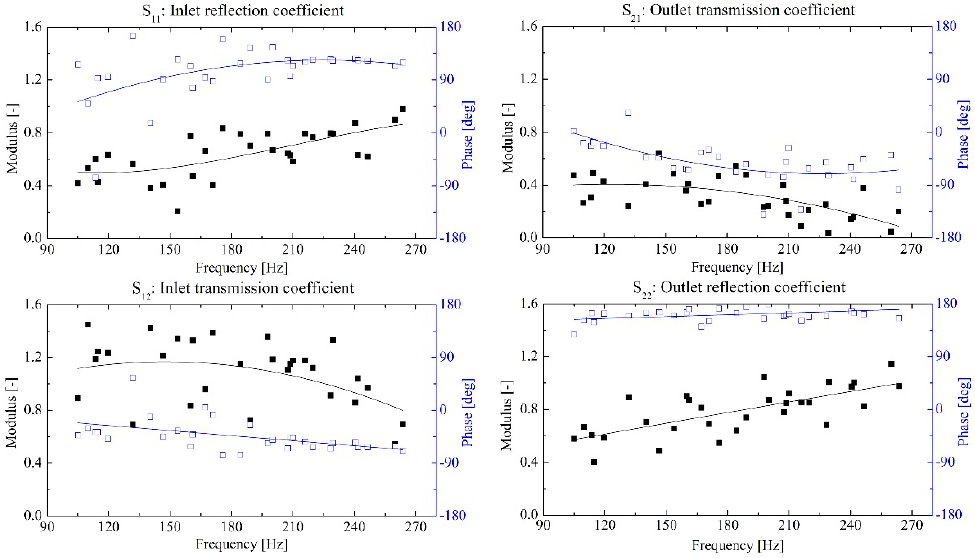
Figure 4. Measured data for pump scattering